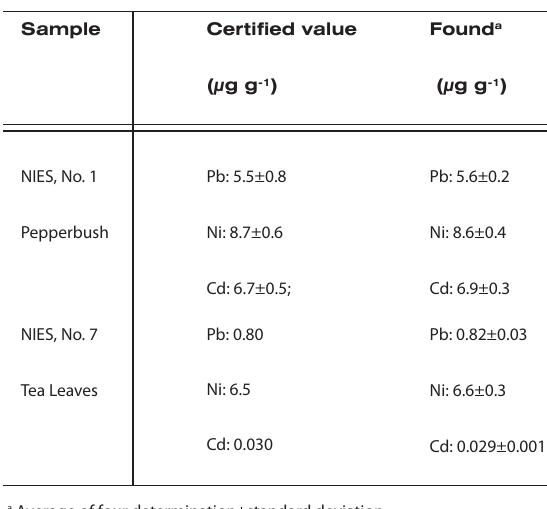
Table 6. Determination of Pb(II), Ni(II) and Cd(II) ions in certified reference